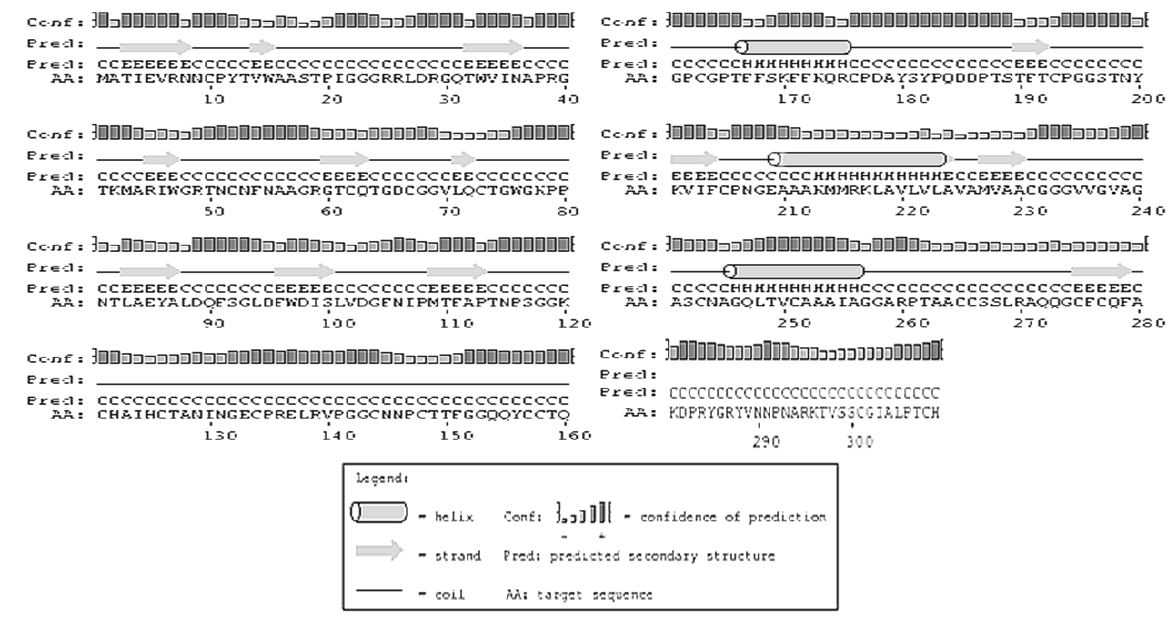
Fig. 2. Prediction of the secondary structure of the fused protein.